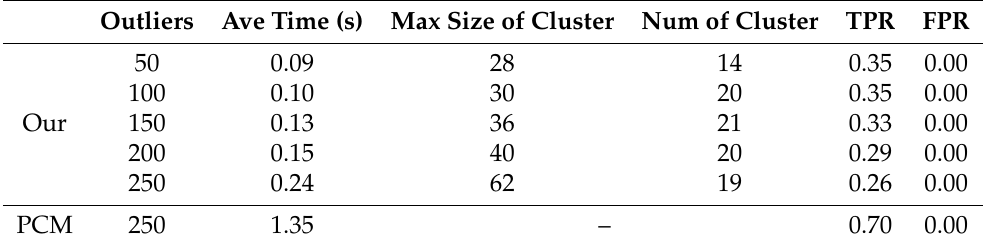
Table 1. Simulation Results: